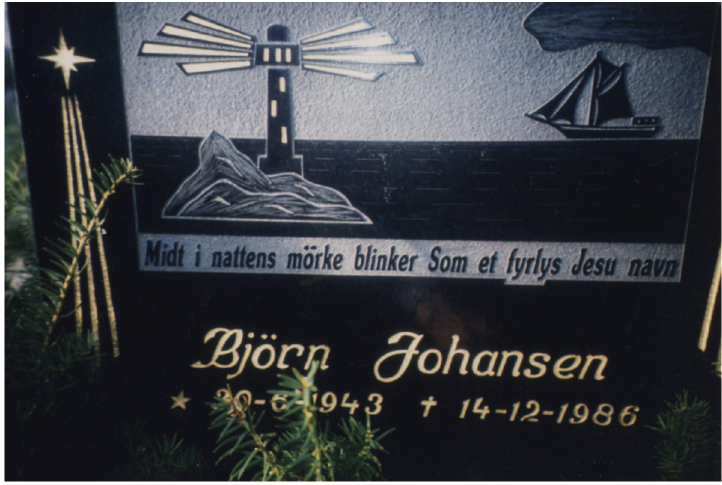
Figure 3. A maritime design showing a ship at sea together with a lighthouse and the Christian inscription, “In the gloom of night Jesus’ name shines out like a lighthouse”. There is also a shining star to the left. Gravestone for a forty-three-year-old man at Vestre Gravlund cemetery, Oslo, 1986. Photo: Anders